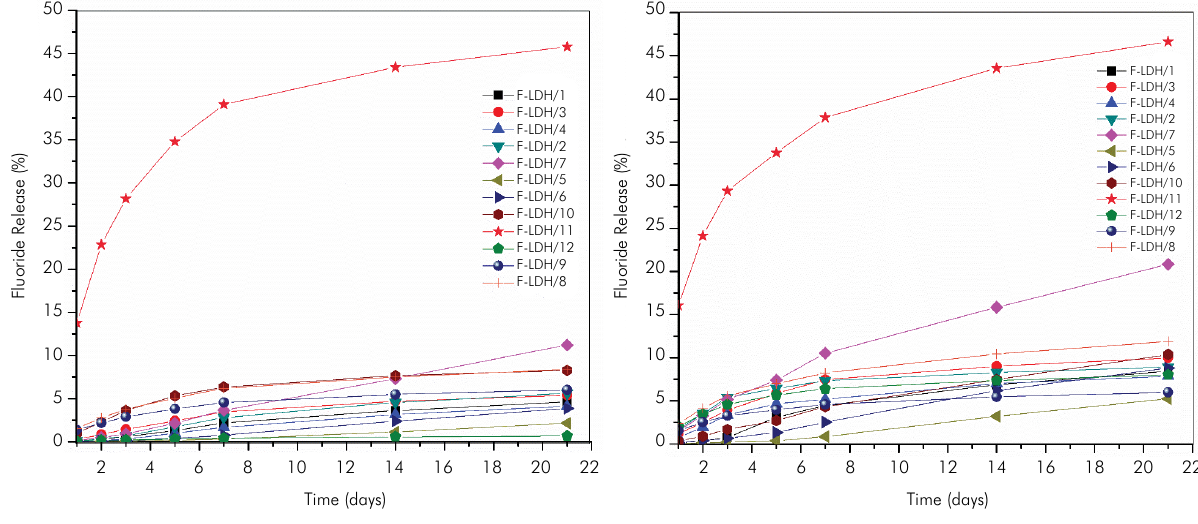
Figure 5. Kinetic curves for fluoride (F - ) release for all samples. Neutral (A) and acidic (B) mediums. Note, the acid medium showed a higher F - amount among all F-LDH/11 products synthesized (at 25°C for 24 h) from the N-LDH powder. It showed the best value: 45.7% (pH= 7.0) (A) and 46.6% (pH = 5.5)